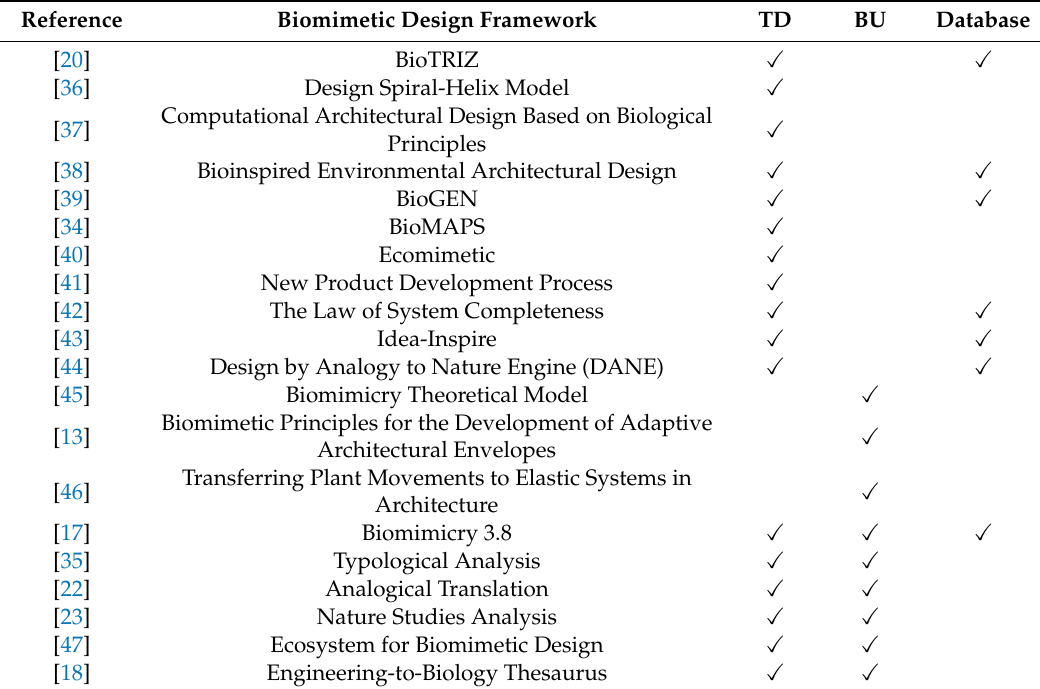
Table 1. List of existing biomimetic design frameworks (TD: Top-down, BU: